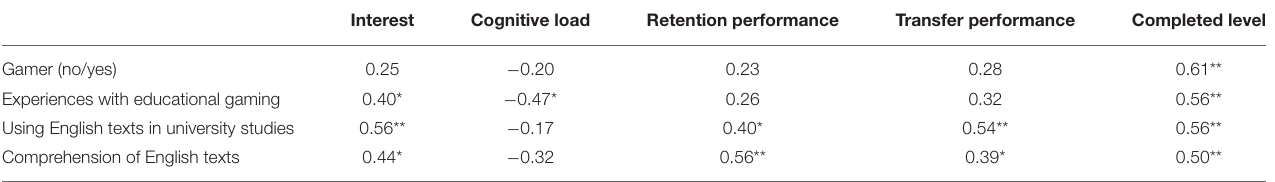
TABLE 10 | Correlations of learning experience and English comprehension skills with interest, cognitive load, performance, and completed level. Interest Cognitive